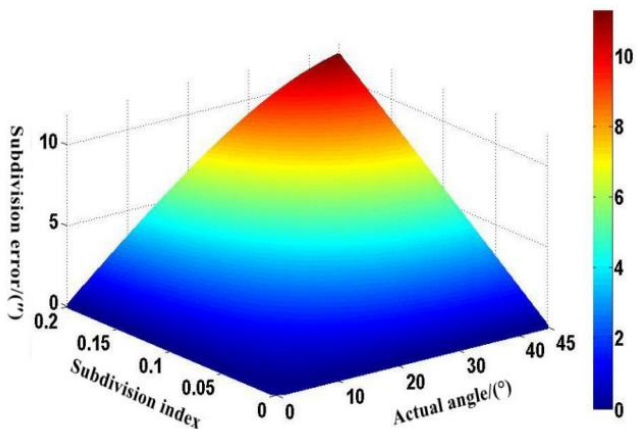
Figure 3. Subdivision error introduced by signal sinusoidal error [19].